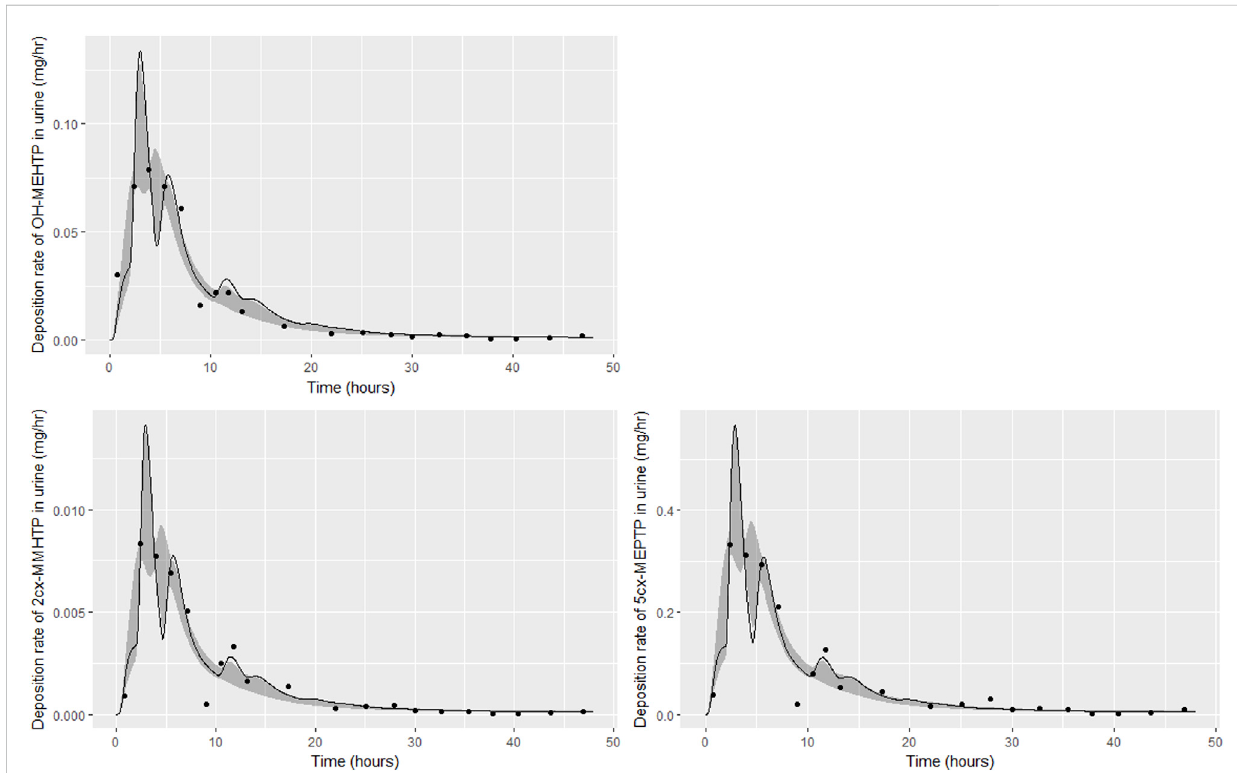
FIGURE 6 Fit of the calibrated model to urinary excretion data from individual (C) . Panel (A) OH-MEHTP (mg/h); (B) 2cx-MMHTP (mg/h); (C) 5cx-MEPTP (mg/ h). The central estimates indicated in plots correspond to the posterior mode whereas the shaded regions represent 95% intervals for the respective